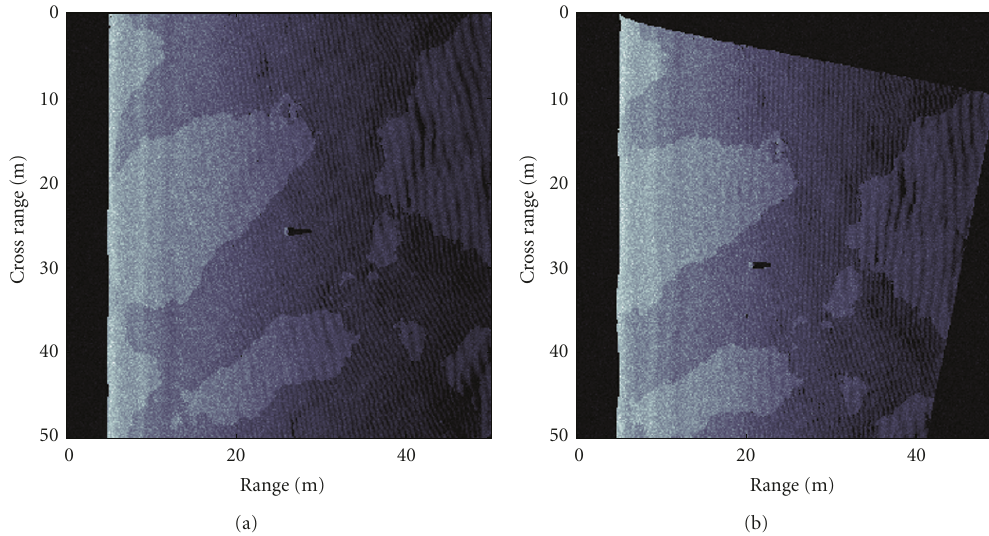
Figure 7: Display of the resulting sidescan images ((a) and (b)) of the same scene with di ff erent trajectory. The seafloor is composed with two sand ripples phenomena at di ff erent frequencies and di ff erent sediments (VeryFineSand for the high frequency ripples and VeryCoarseSand for the low frequency ripples). A manta object has been put in the centre of the map.